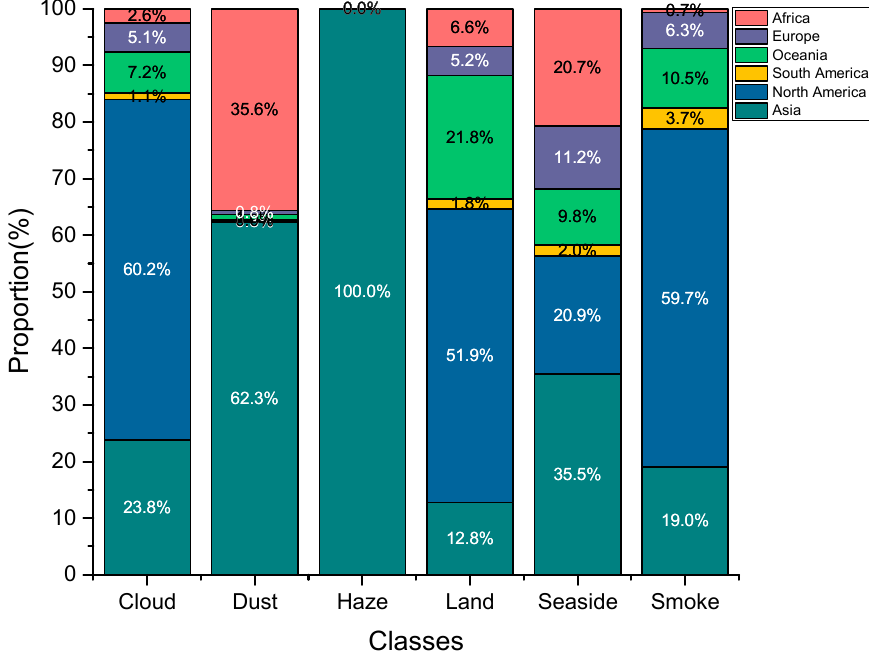
Figure 1. Spatial distribution of six classes of images in the USTC_SmokeRS dataset. The statistics of geographic location of the images are based on the seven-continent model [60].